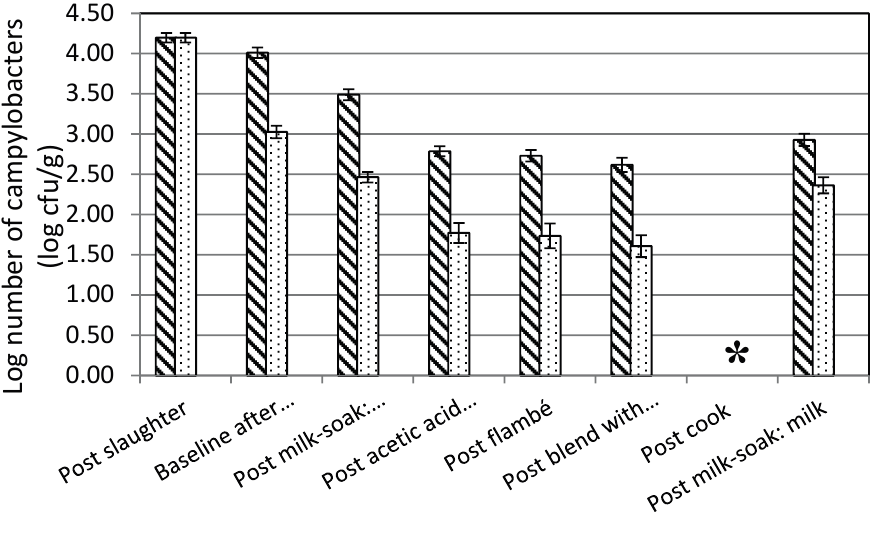
Figure 4. The numbers of campylobacters present in chicken livers at each stage of a protocol used for the manufacture of chicken liver pâté. Livers were either stored chilled at 2 °C for 48 h (diagonal hatch) or frozen to − 20 °C for 24 h and thawed for 24 h (speckled dots) before the commencement of pâté manufacture. Error bars are the standard error of the mean log. An asterisk ( * ) denotes a sample that did not contain campylobacters determined by enrichment.